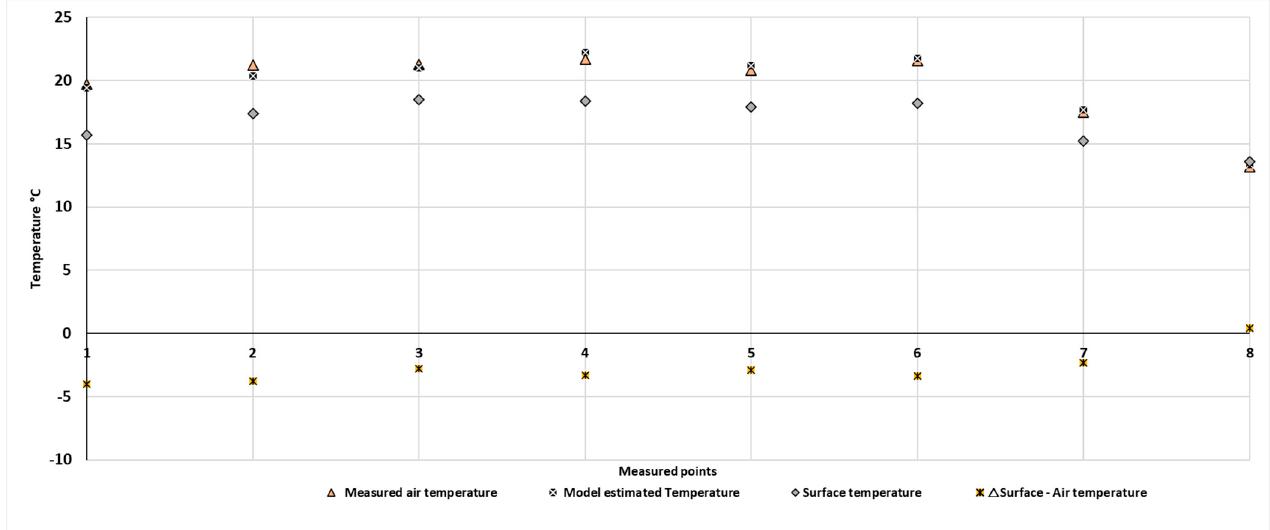
Figure 5. Measured air temperature (MAT), model – estimated temperature (MET), and surface temperature (ST) extracted from the measurement point, as well as the difference between measured and surface temperature ( △ ST - MAT). Data source: USGS (2021); data recording on 10 May 2020. Organized by the authors, December 2021.